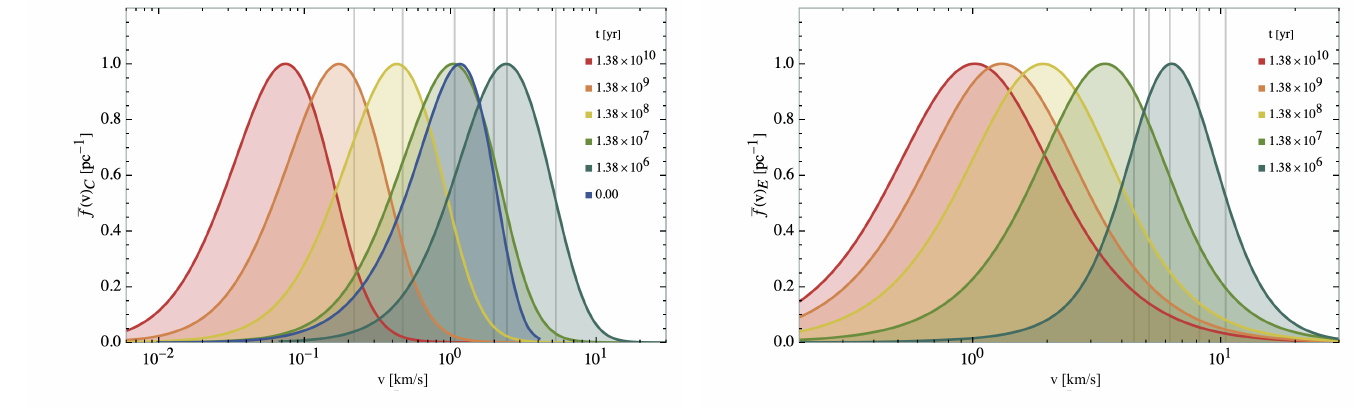
Figure 12. Density, position and velocity quasi-static profiles segregated by population (cluster and ejecta) type at selected times. Fits for the mass, position, velocity and density probability distributions are given in Table 14. Note the mass distribution is not displayed as, first, the absence of a significant number of mergers implies that the evolution of the total mass profile of objects has an almost negligible evolution, and second, as seen in Table 14, the cluster and ejecta mass profiles do not segregate significantly over